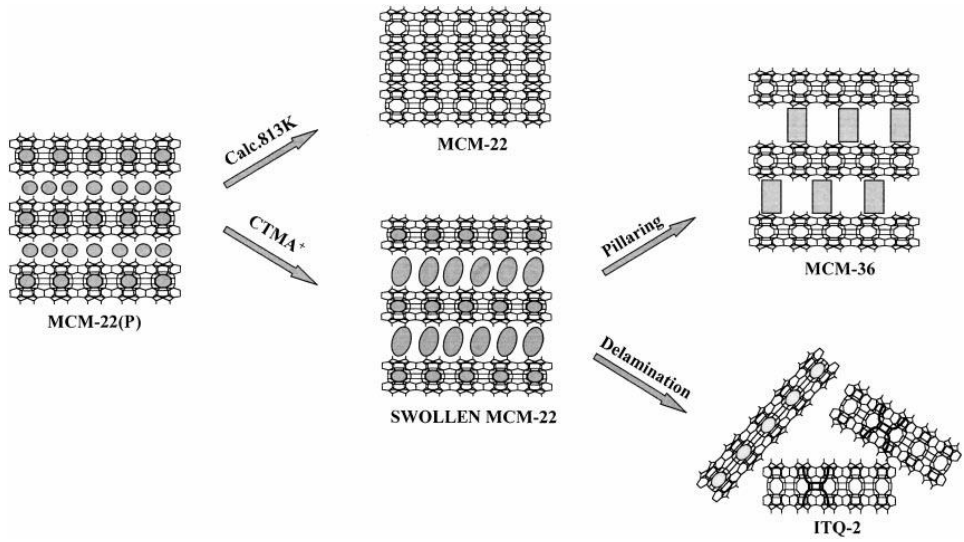
Figure 4. Schematic representation of various derivates from the MCM-22 precursor. Reprinted with permission from ref. [43]. Copyright 1999 Elsevier.